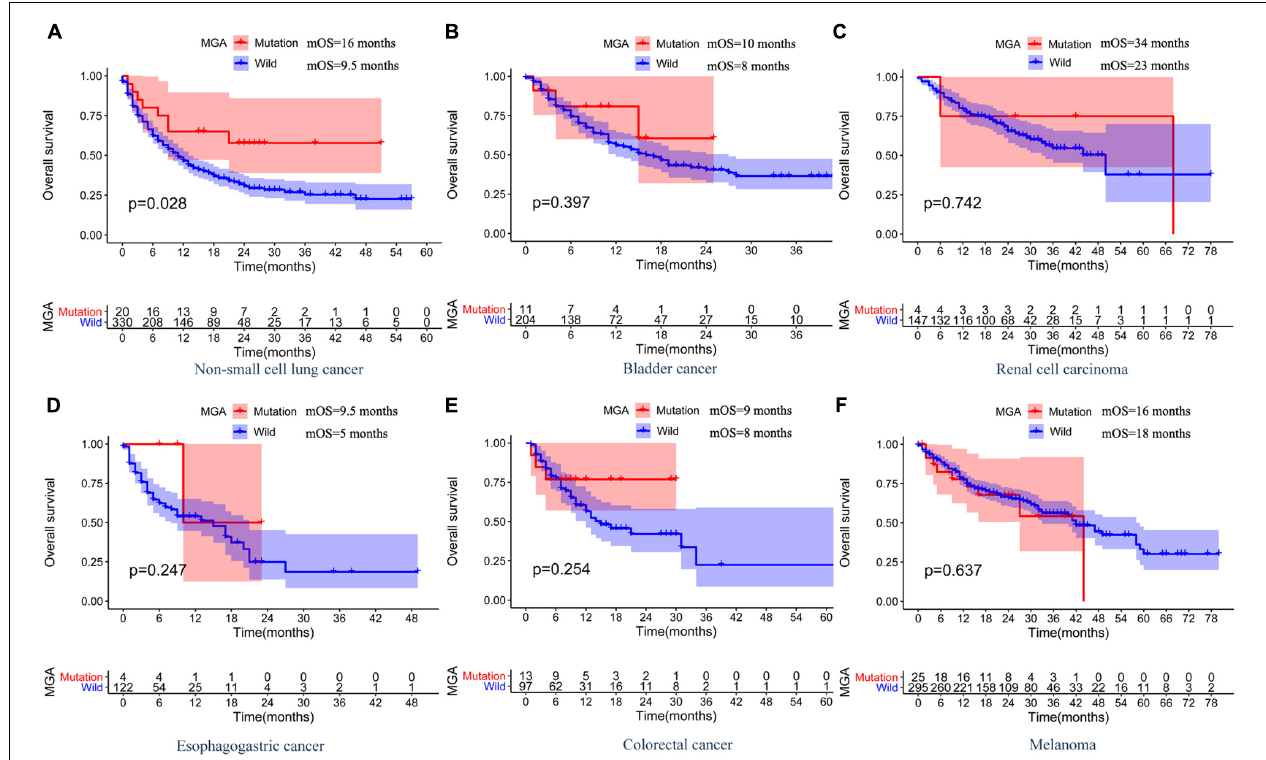
FIGURE 2 | The associations between MGA mutation and OS and in ICI-treated MSKCC pan-cancer cohort. Kaplan-Meier curves of OS between MGA mutant and the wide-type group among patients with NSCLC (A) , bladder cancer (B) , renal cell carcinoma (C) , esophagogastric cancer (D) , colorectal cancer (E) , and melanoma (F)